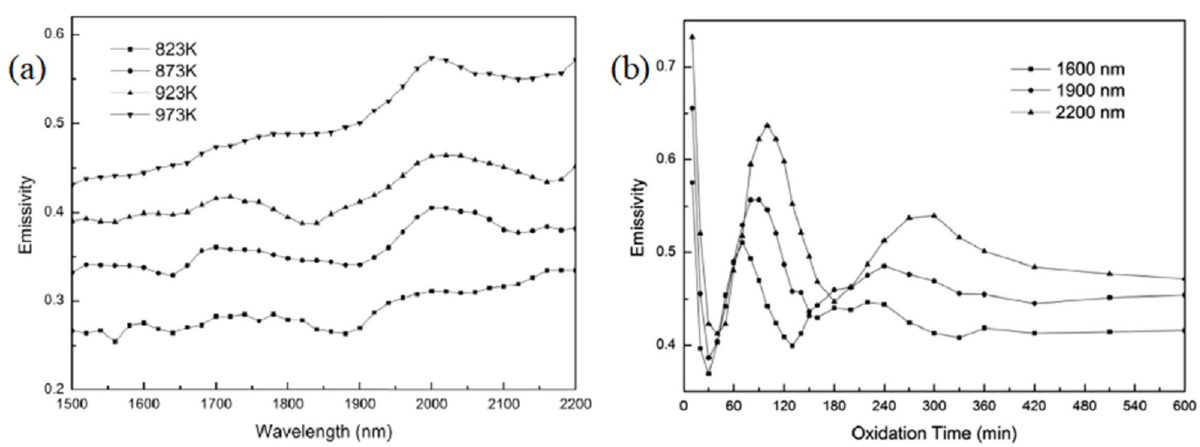
Figure 8. The emissivity of Ti6Al4V alloy as a function of wavelength/temperature ( a ) and oxidation time ( b ). Sample in ( b ) oxidized at 973K